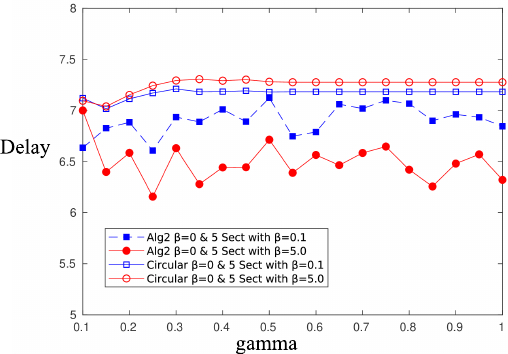
Figure 17. Delay of information reception, Algorithm 2 vs. circular selection of sectors.